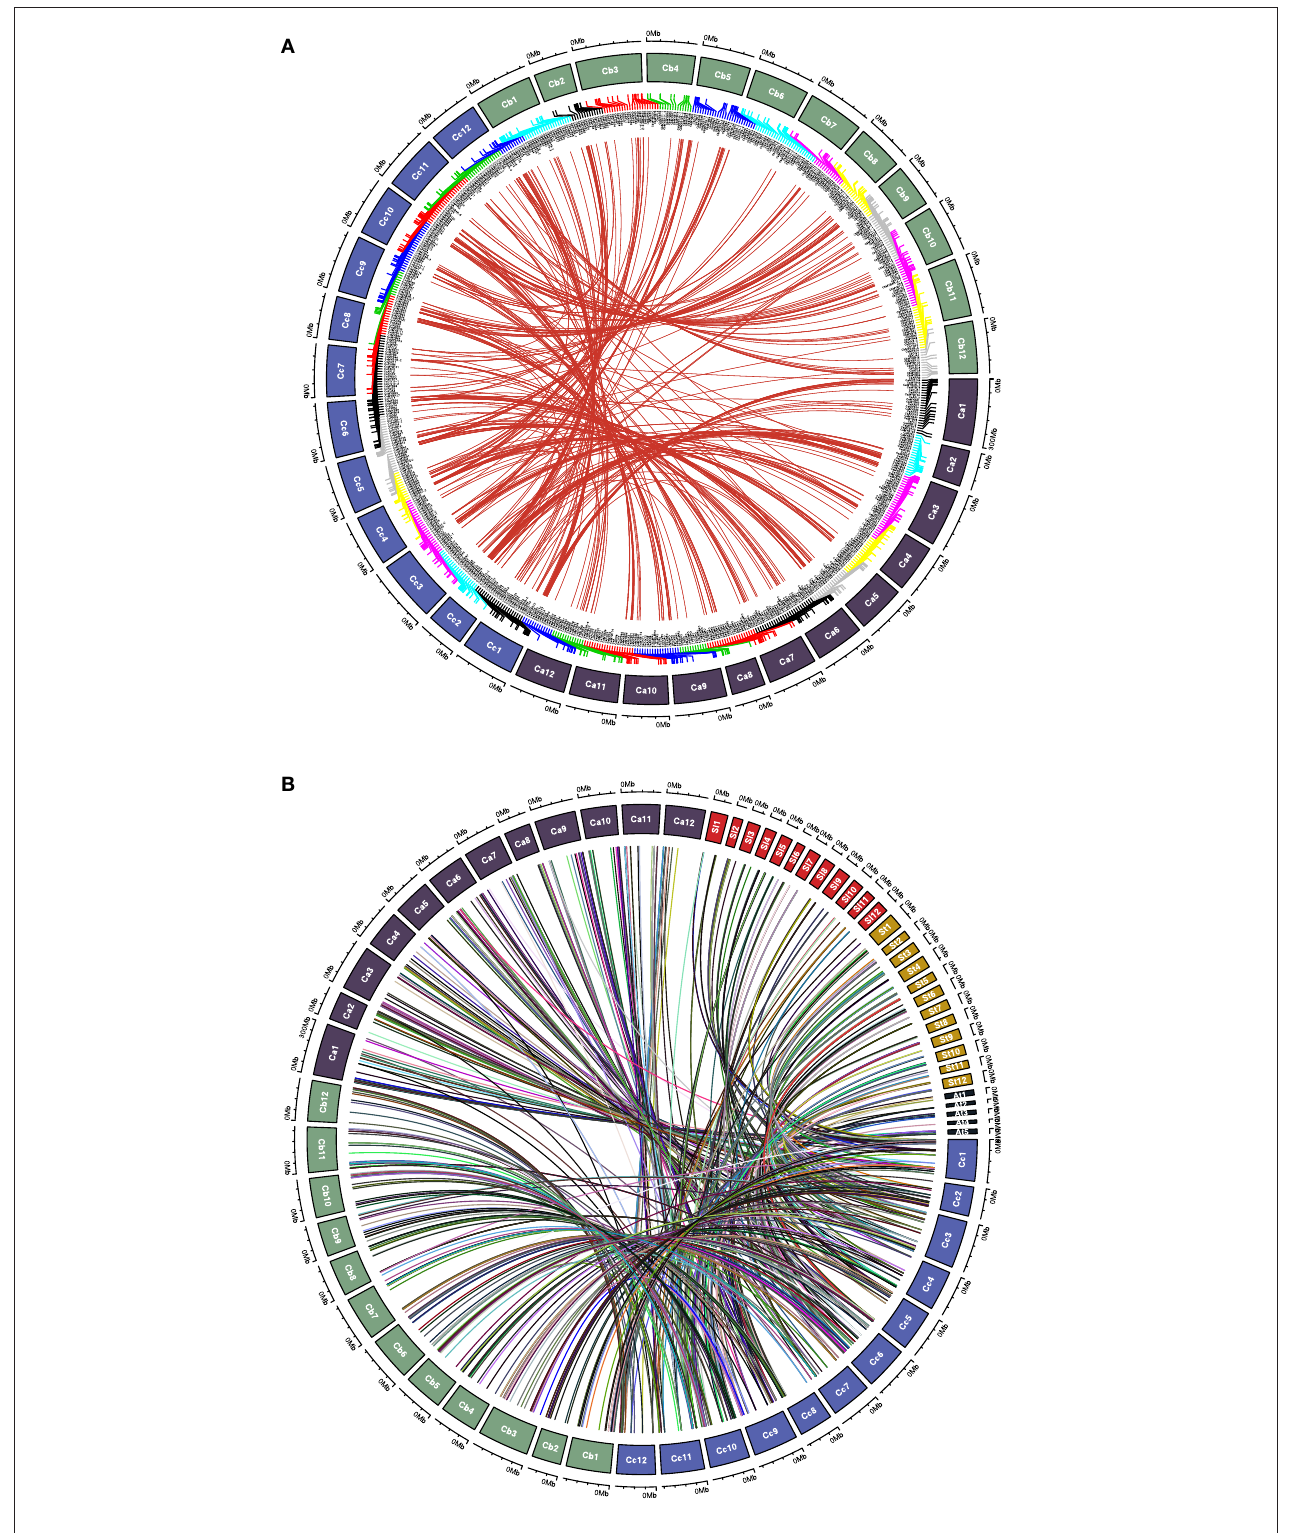
FIGURE 9 | Chord diagram representing (A) syntenic CcMYB gene pairs with C. annuum and C. baccatum MYBs and (B) CcMYB homologs in C. annuum , tomato (Sl), potato (St), and Arabidopsis (At) across their respective chromosomes.